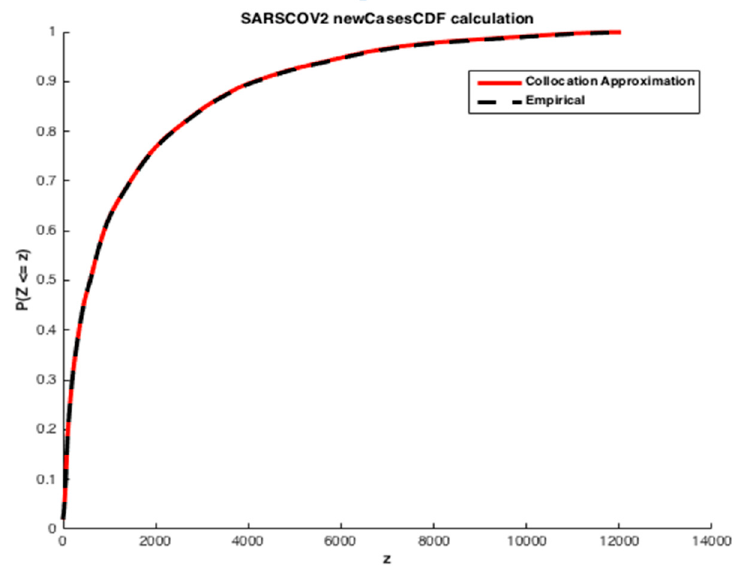
Figure 11. Estimation of the cumulative density function of the number of infected people by SARS-CoV-2 in Morocco. The results furnished by collocation.